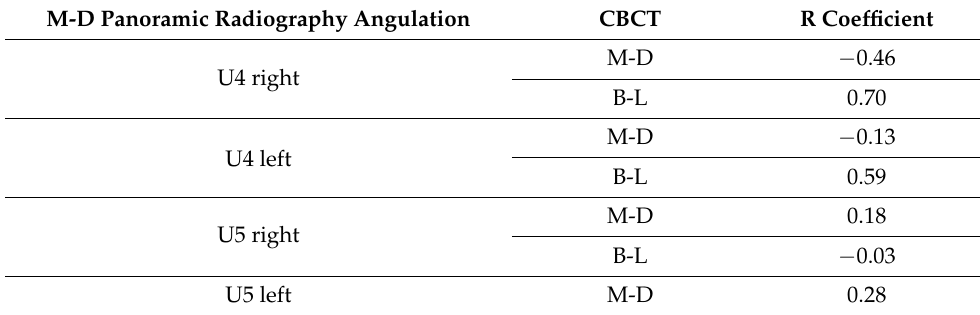
Table 2. Results of Pearson rho correlation analysis. Low or no correlations are shown among mesiodistal angulation in panoramic radiography and in CBCT for first and second premolars. Medium-high correlations are shown among panoramic radiography mesiodistal (M-D) angulation and CBCT buccolingual (B-L) inclination for the first premolars. Low correlations are shown among mesiodistal angulation in panoramic radiography and both mesiodistal angulation and buccolingual inclination on CBCT for second